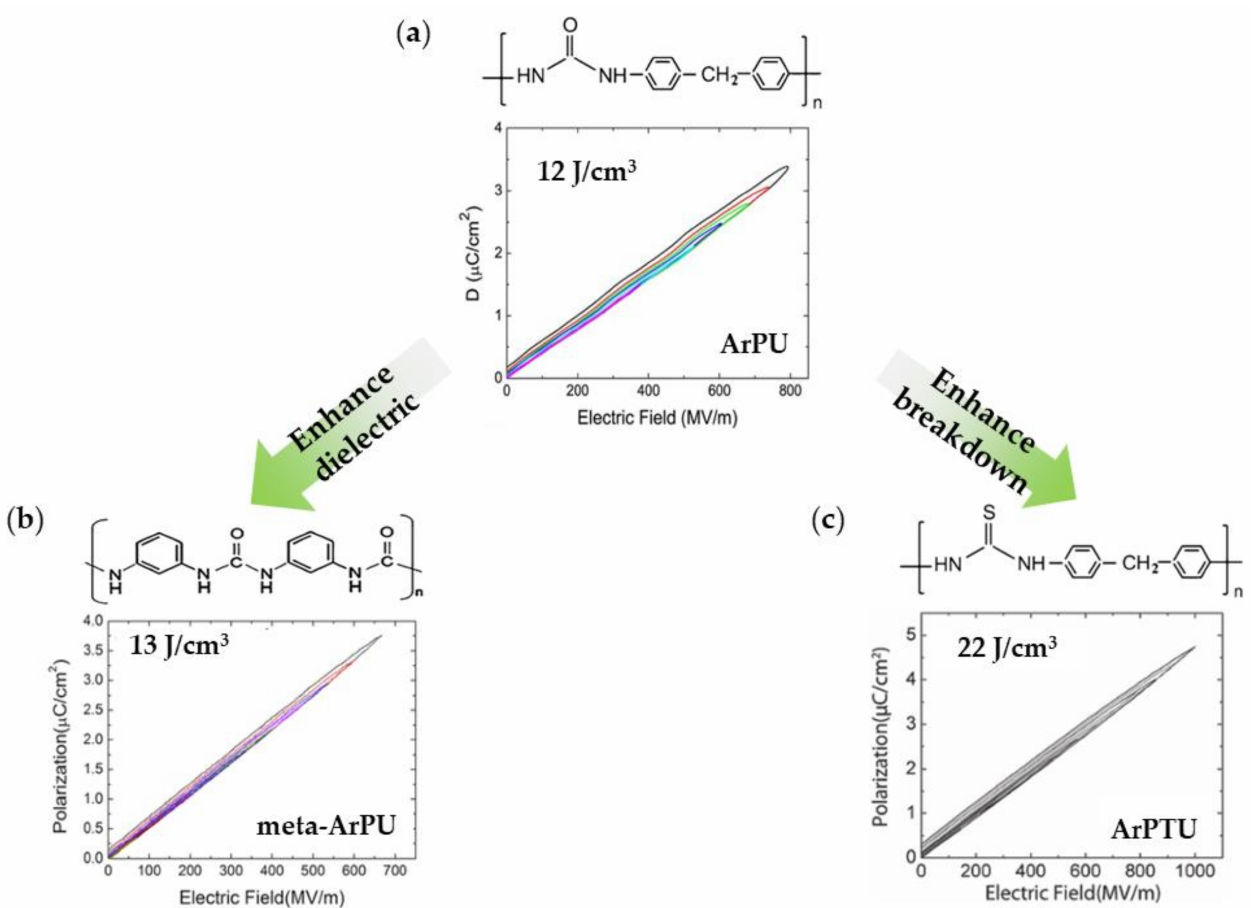
Figure 10. ( a ) The P-E loop with molecular formula ArPU, ( b ) meta-ArPU, and ( c ) ArPTU. Adapted from [110–113] with permission. Copyright (2017), Royal Society of